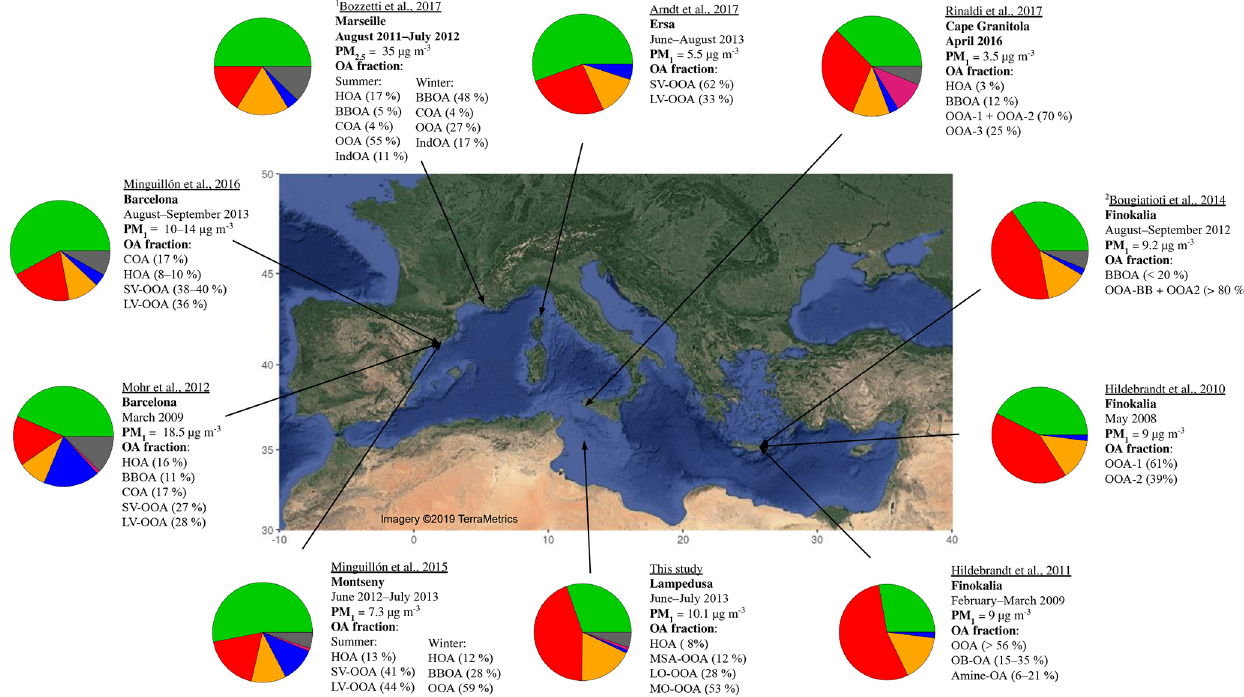
Figure 8. A summary of studies that have investigated NR-PM 1 composition (including PMF of OA) around the Mediterranean basin. Only studies that have investigated PMF-based OA source apportionment are reported. Pie charts display the average concentration during each study, where green corresponds to organics, red to sulfates, orange to ammonium, blue to nitrate, pink to either chlorides or sea salt and black to elemental or black carbon. The OA fraction acronyms correspond to the following: HOA: hydrocarbon-like organic aerosol, SV-OOA: semi-volatile oxygenated organic aerosol, LV-OOA: low-volatility oxygenated organic aerosol, BBOA: biomass burning organic aerosol, COA: cooking organic aerosol, OOA: oxygenated organic aerosol, F4: factor 4 (unidentified PMF factor), IndOA: industry-related organic aerosol, OB-OA: olive-branch organic aerosol. See Tables S1 and S2 for further details about the sampling locations, instruments used and pie chart values. 1 This study collected on PM 2 . 5 filters and nebulized into an HR-ToF-AMS. 2 Excludes fire periods.